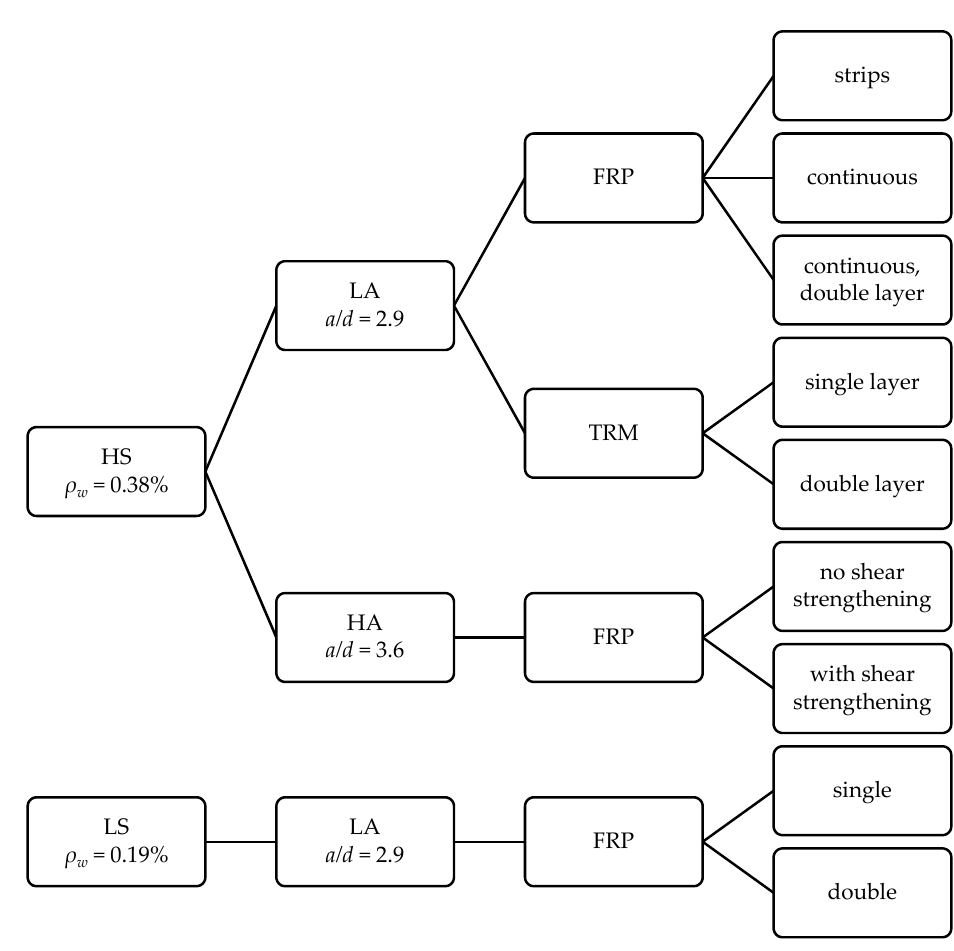
Figure 1. Summary of test parameters.